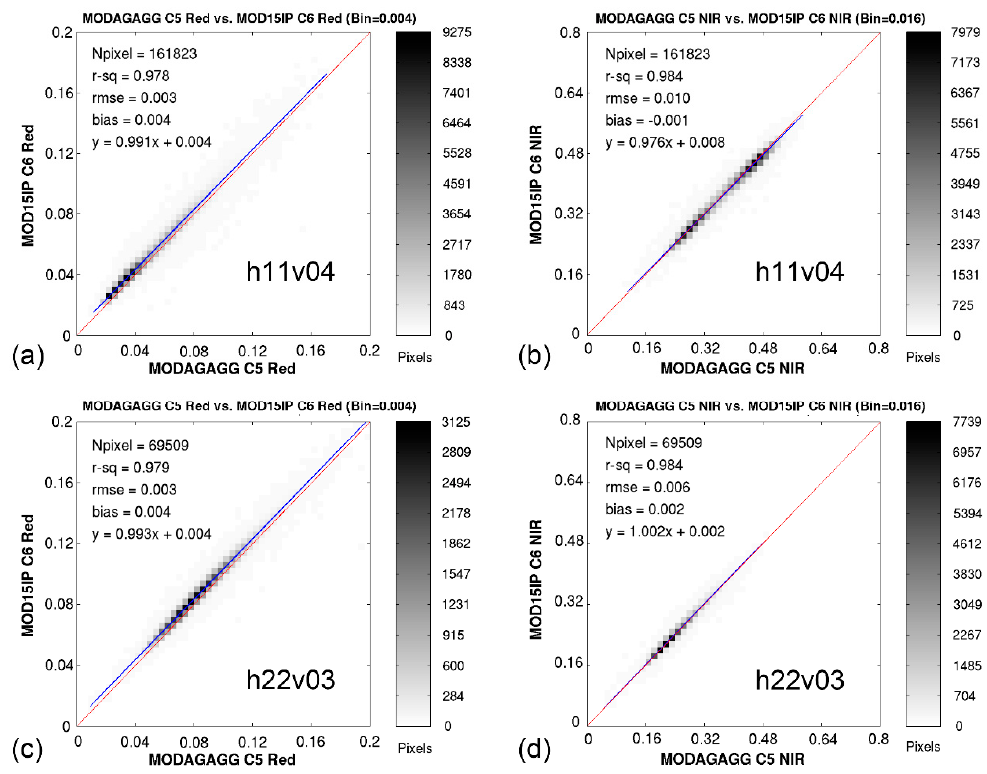
Figure 8. Density scatter plots of land surface reflectance (BRFs) of red band (left panels) and NIR band (right panels) of the two example tiles ( a ) and ( b ) are for tile h11v04; ( c ) and ( d ) are for h22v03) shown as boxes in Figure 7.